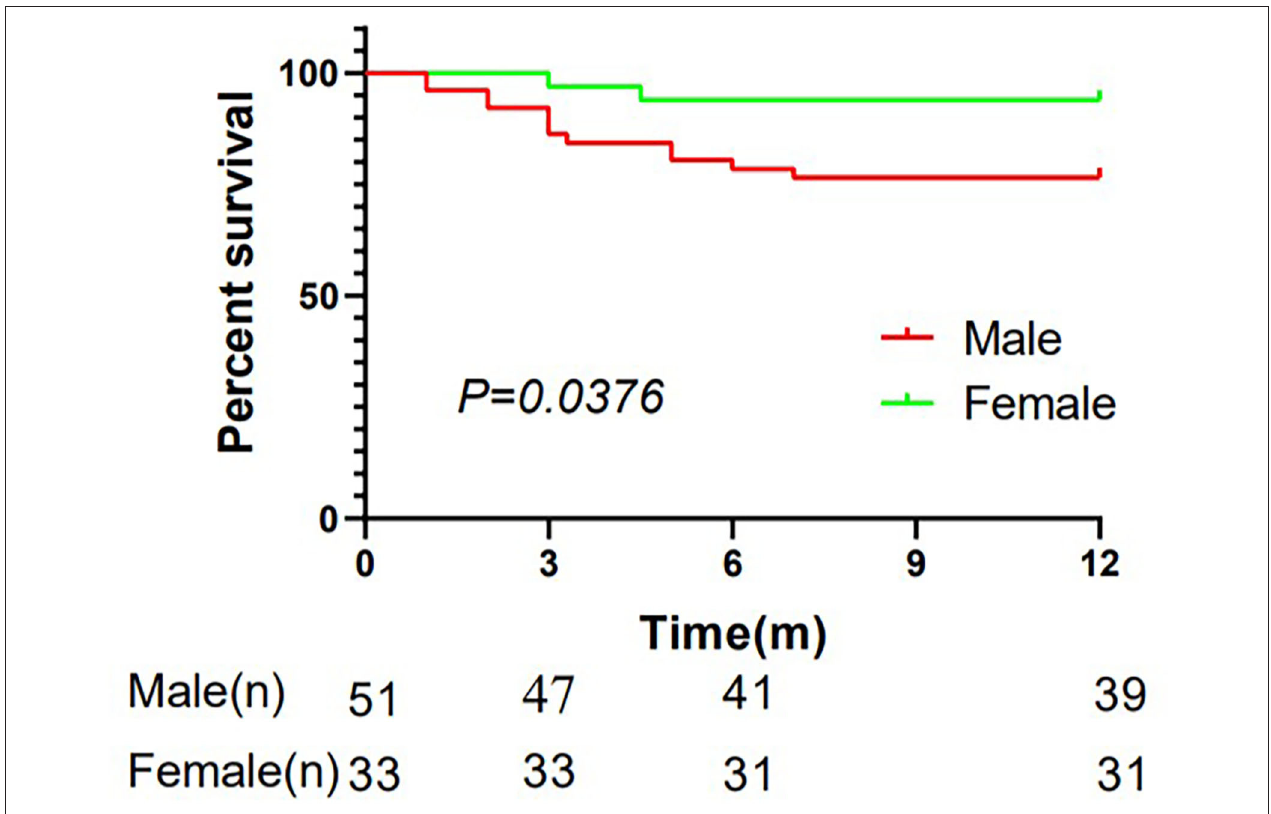
FIGURE 1 | Kaplan–Meier plots demonstrating the mortality ratio of patients with AAV in males and females in the 1-year follow-up. 84 patients were included and 70 survived in the first year after diagnosis with 39 males and 31 females. The Kaplan-Meier (K-M) survival curves indicated that the 1-year mortality ratio was higher in male patients than in female patients ( P = 0.0376). m,